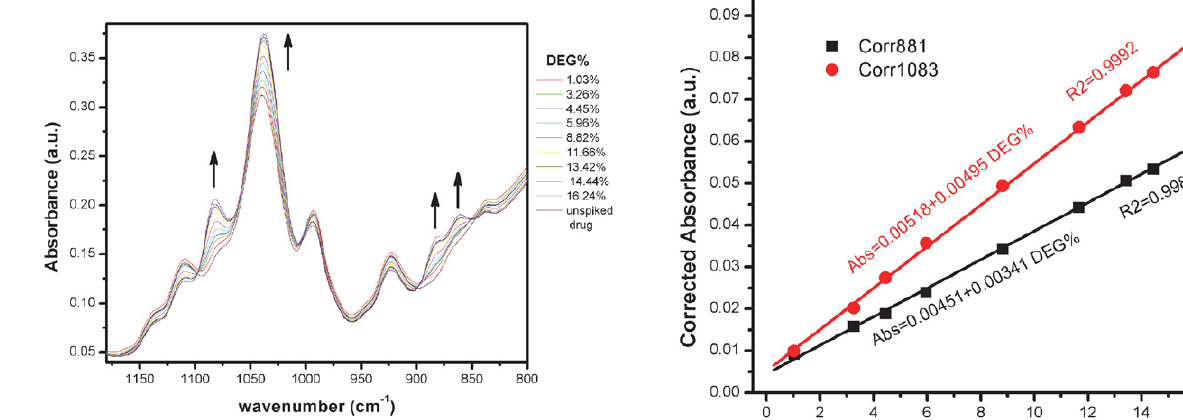
Figure 4. Corrected DEG absorbance at 881 cm –1 and 1083 cm –1 versus its percentage in spiked Hederal